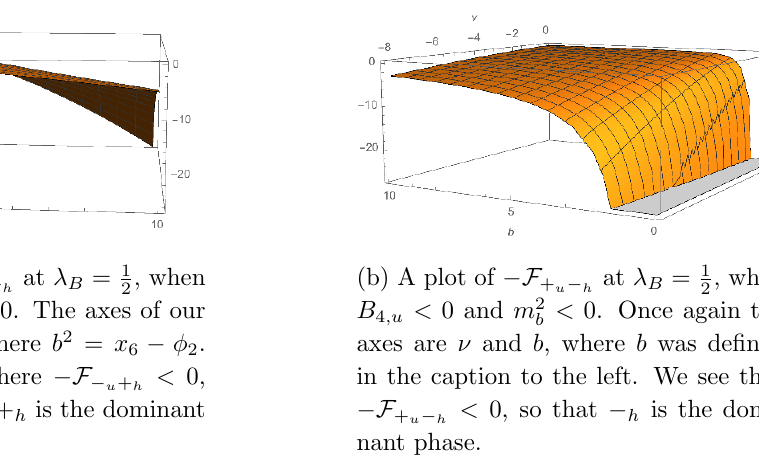
Figure 23. Numerical evaluation of the free energy di(cid:11)erence between two competing